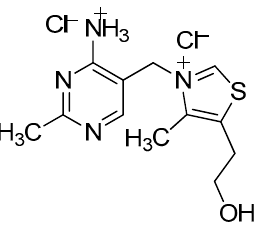
Figure 2. The structure of thiamine hydrochloride (VB 1 ).